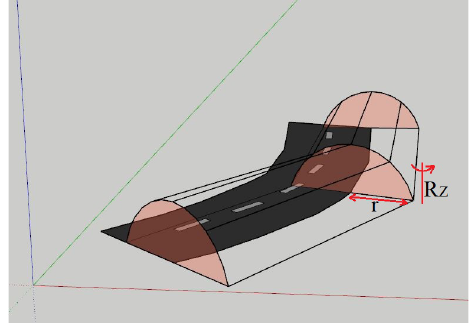
Figure 3 . Noise impacts modelled by using sweeping